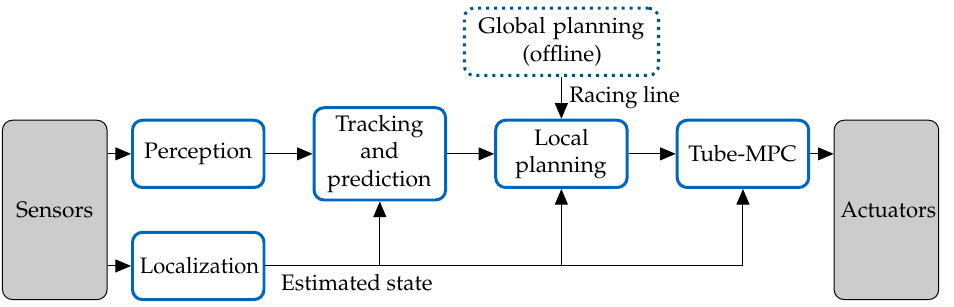
Figure 5. Software architecture: the software of TUM Autonomous Motorsports follows a sequential